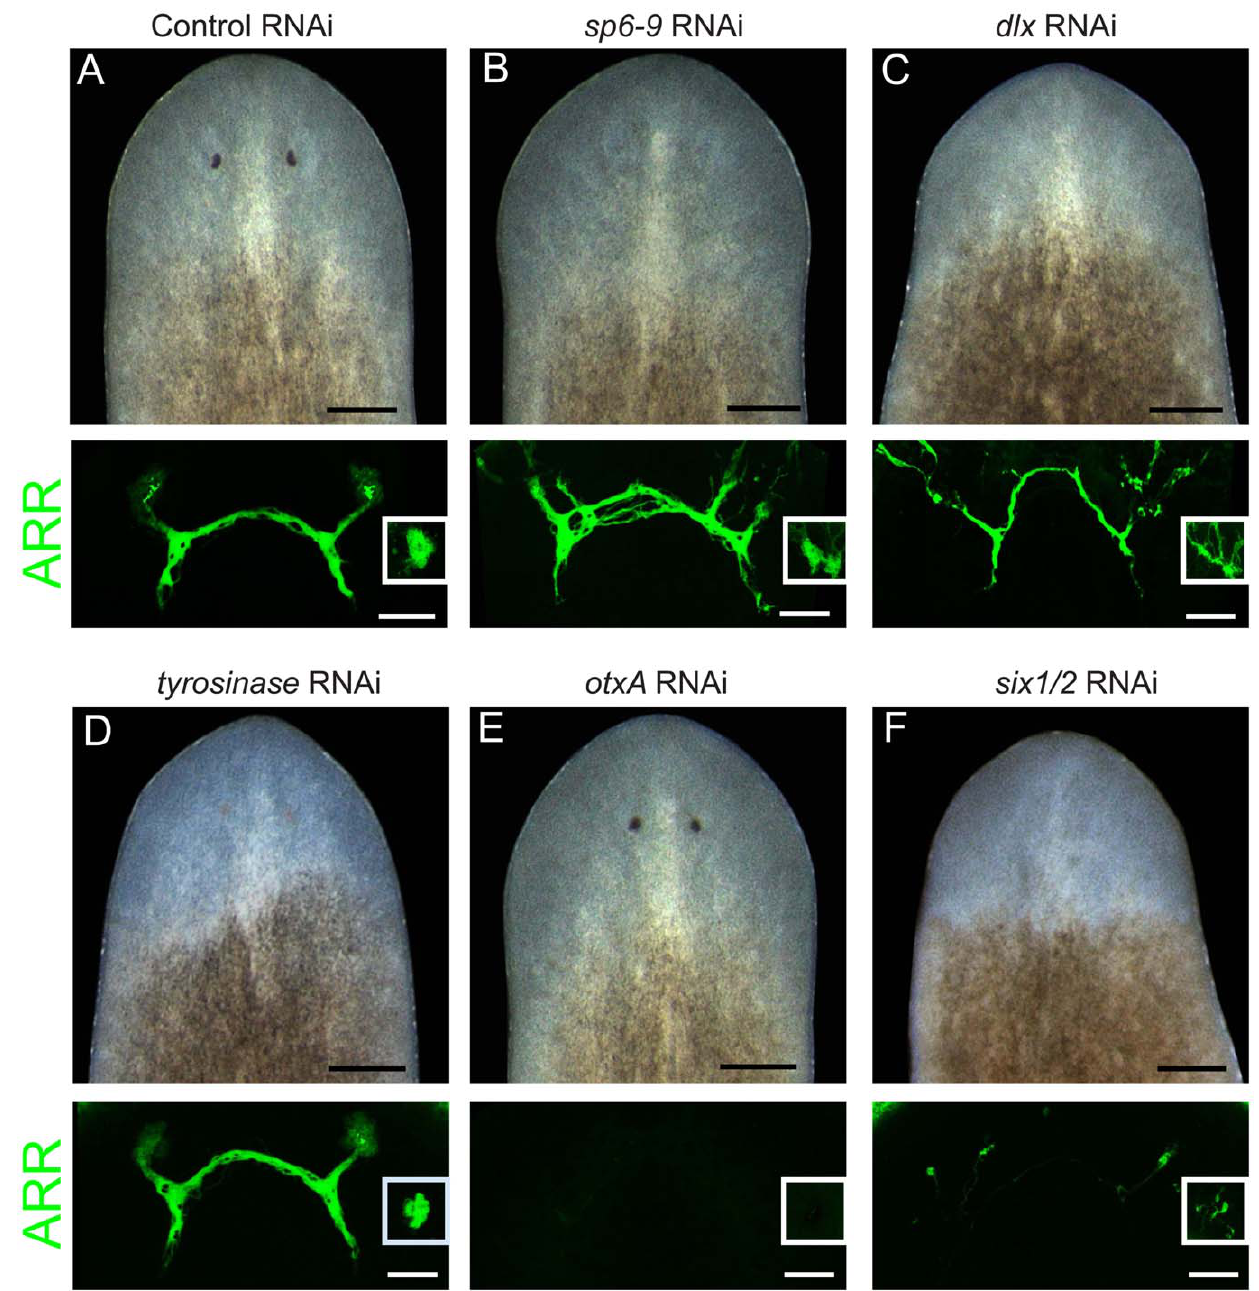
Figure 2. dlx and sp6-9 are required for optic cup regeneration. Pigment cups are visualized in live animals on day 7 of regeneration after decapitation. Photoreceptor neurons are visualized with anti-ARRESTIN (ARR) antibody. Insets in ARR panels show a photoreceptor from the dorsal side. Penetrance in (A) is n=10/10 (presence of pigment cups) and n=6/6 (photoreceptor neurons that contact brain); in (B) n=0/10 and n=9/9; (C) n=0/10 and 9/9; (D) n=0/7 and n=7/7; (E) n=10/10 and n=0/8; (F) n=0/10 and n=3/11. Scale bars, 100 m m for fluorescent images, 200 m m for live worm images. torial FISH, we found that sp6-9 + trail cells co-expressed other trail cells shared molecular similarity with photoreceptor neurons markers of the optic cup, including eya , six1/2 , and dlx (Figure 3B– as well as the optic cup cells, we looked for overlap between 3D and Figure S9A–S9B). The identified trail cells therefore expression of sp6-9 and otxA , which is specifically expressed in the possess an expression profile that is uniquely similar to the optic photoreceptor neurons in the eye. Cells double-positive for these cup; outside of the eye, no other differentiated cell types, including markers or for dlx / otxA were observed only very rarely (Figure 3E the neighboring sp6-9 + head rim cells, were found to be positive for and Figure S9C), indicating that sp6-9 + trail cells share molecular this combination of markers (Figure S10). To test whether sp6-9 + identity with the pigment cup, but not with photoreceptor